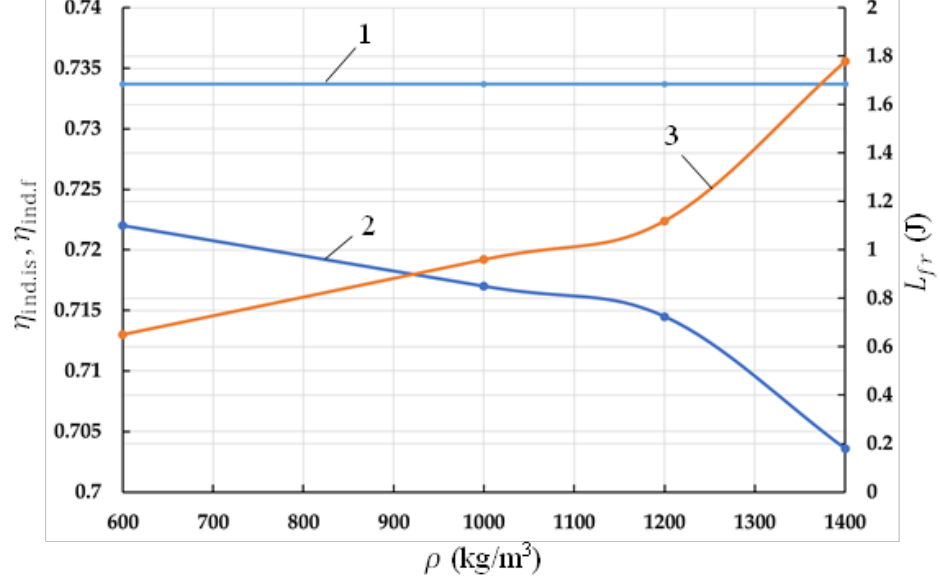
Figure 15. Dependence of the indicator isothermal efficiency, total indicator efficiency, and work of friction forces on the liquid density (1- 𝜂 ind.is ; 2- 𝜂 ind.f. ; 3- 𝐿 𝑓𝑟 ).